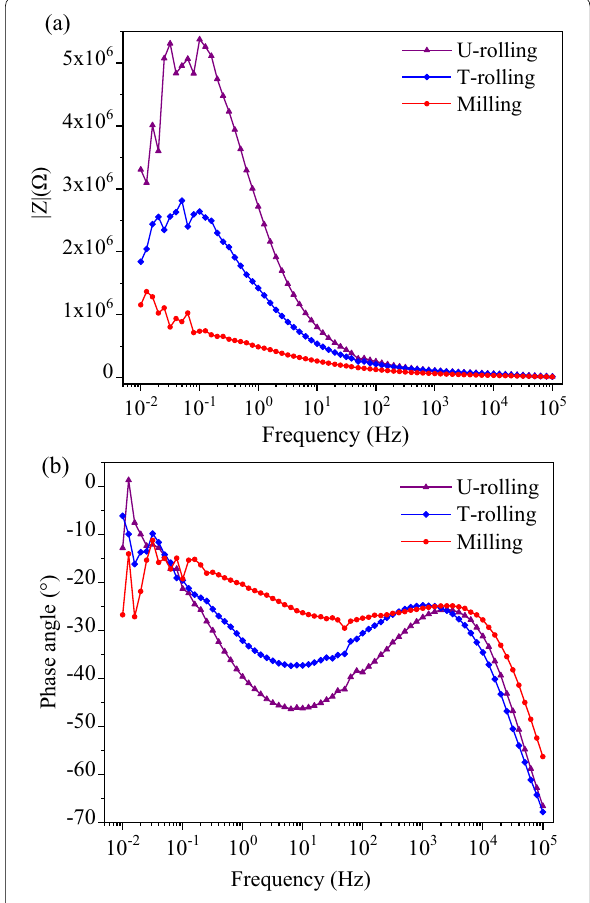
Figure 9 Bode curve of samples: ( a ) Frequency–amplitude, ( b ) Frequency–phase